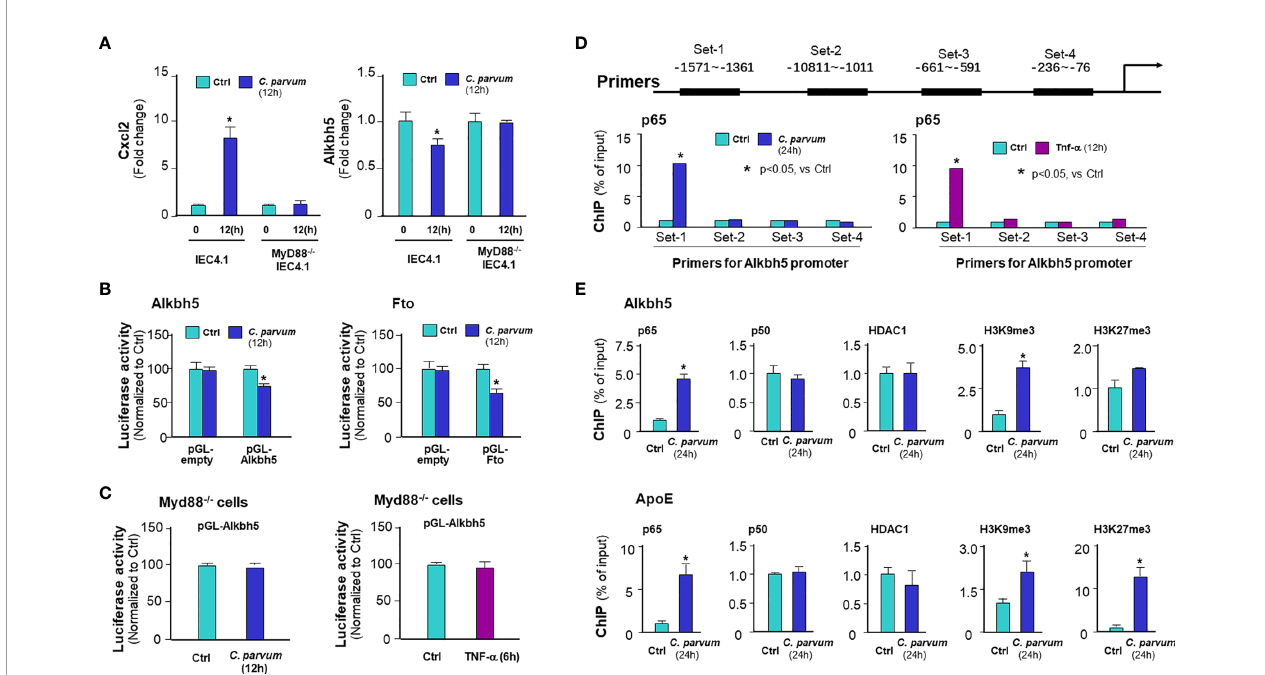
FIGURE 3 | C. parvum infection causes downregulation of Alkbh5 and Fto with the involvement of NF- к B signaling activation. (A) Downregulation of Alkbh5 in IEC4.1 cells following C. parvum infection is MyD88-dependent. Knockout MyD88 in IEC4.1 cells blocked the suppression of Alkbh5 induced by C. parvum . Cxcl2 induction in cells in response to infection was also measured for positive control. (B) Luciferase activity associated with the promoters of both Alkbh5 and Fto genes in IEC4.1 cells following C. parvum infection. Cells were transfected with the generated reporter constructs and then exposed to C. parvum infection for 12h, followed by measurement of luciferase activity. Cells transfected with the empty vector were used as control. (C) Luciferase activity associated with the promoter of Alkbh5 in MyD88-/- IEC4.1 cells following C. parvum infection or TNF- a stimulation. IEC4.1 cells de fi cient in Myd88 were exposed to C. parvum infection (for 12h) or TNF- a stimulation (for 6h). Luciferase activity was measured. (D) Recruitment of NF- к B p65 to the Alkbh5 promoter region in IEC4.1 cells following C. parvum infection or TNF- a stimulation. Cells were exposed to C. parvum infection (for 24 h) or TNF- a stimulation (for 4h), followed by ChIP analysis using anti-p65 and the PCR primer sets as designed. Increased recruitment of p65 was detected in the -1571~-1361 (Set-1) region of the Alkbh5 gene locus in cells following C. parvum infection or TNF- a stimulation. (E) Recruitment of NF- к B subunits and HDAC1, as well as enrichment of H3K9me3 and H3K27me3, at the Alkbh5 promoter region in intestinal epithelial cells following C. parvum infection. Cells were exposed to C. parvum infection for 24 h, followed by ChIP analysis using anti-p65, anti-p50, anti- HDAC1, anti-H3K9me3, or anti-H3K27me3 and the PCR primer Set-1. Recruitment of NF- к B subunits and HDAC1, as well as enrichment of H3K9me3 and H3K27me3, at the ApoE promoter region in cells following C. parvum infection were also measured as a positive control. Data represent three independent experiments. *p<.05 vs the non-infected